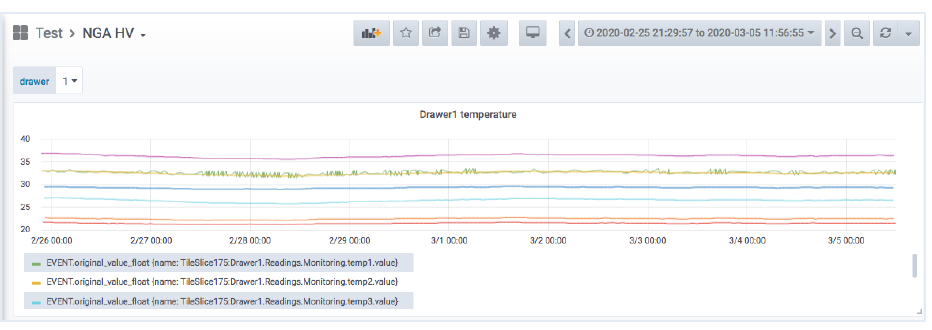
Fig. 7. Temperature probes inside